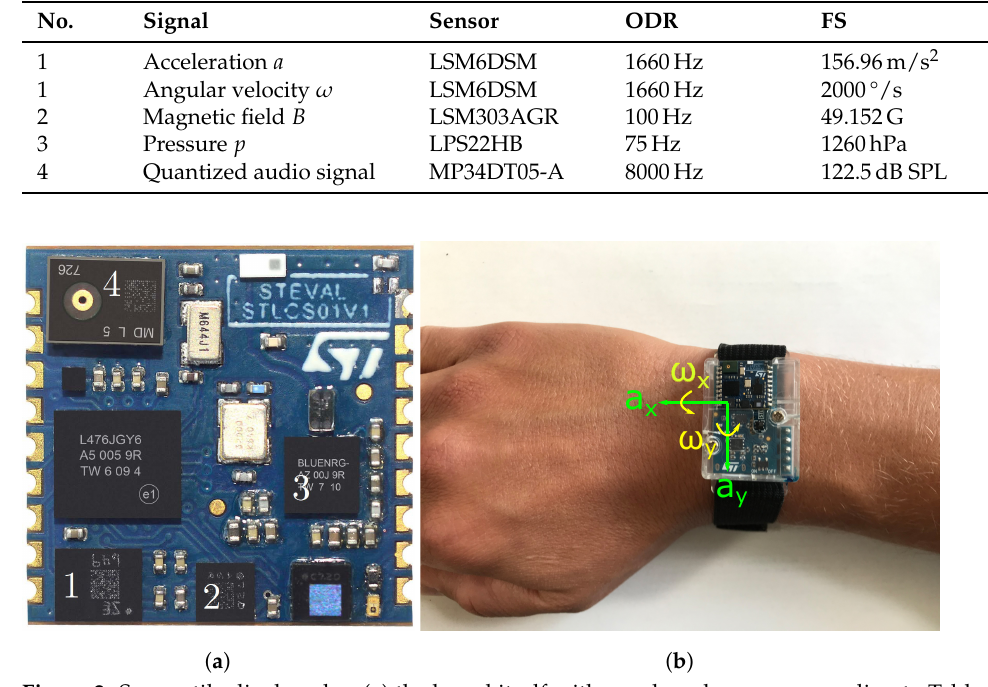
Figure 2. Sensor tile displayed as ( a ) the board itself with numbered sensors according to Table 2, adapted from [24], and ( b ) the complete wearable with marked sensor axes, worn on the wrist. The axes for the accelerometer a x , a y , and the gyroscope ω x , ω y are